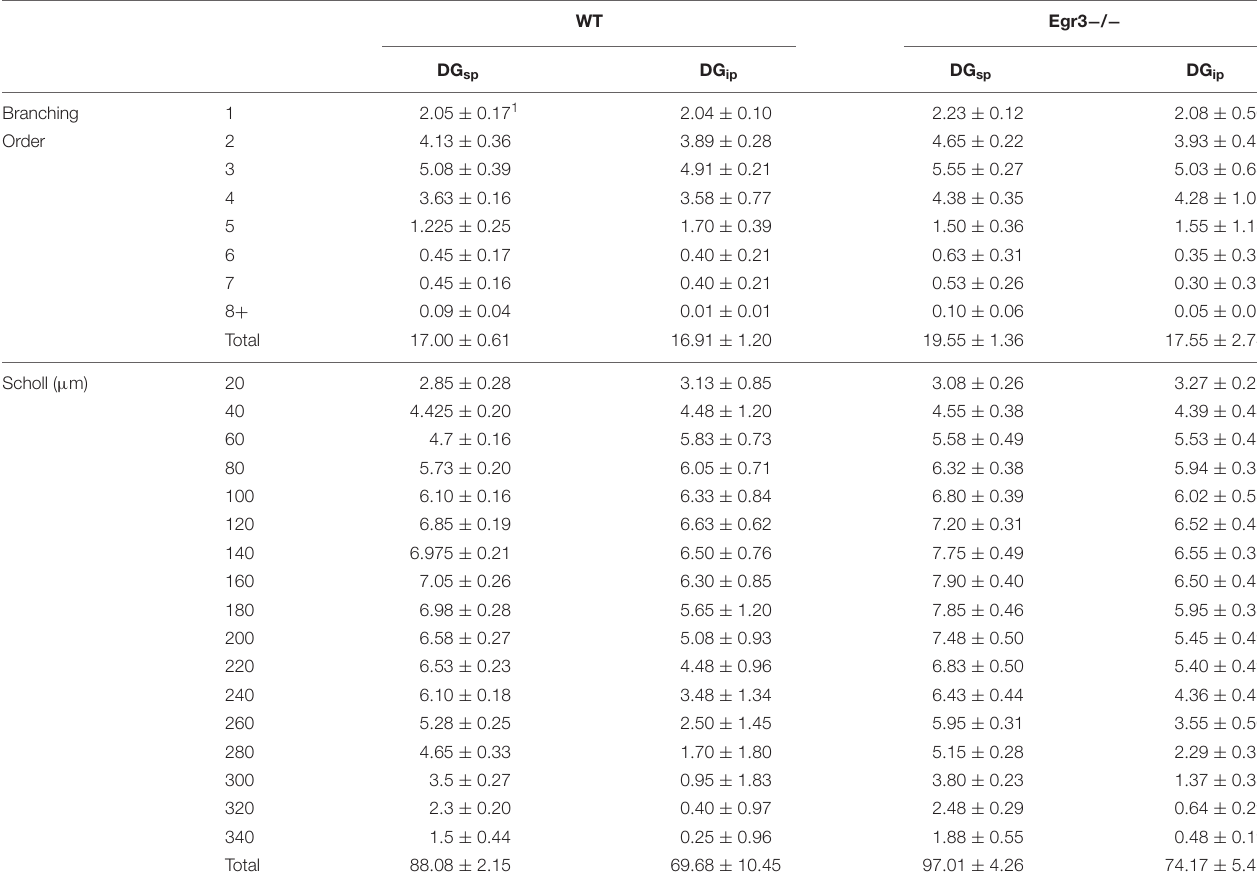
TABLE 3 | Dendritic arborization in granule cells of WT and Egr3 − / − mice.